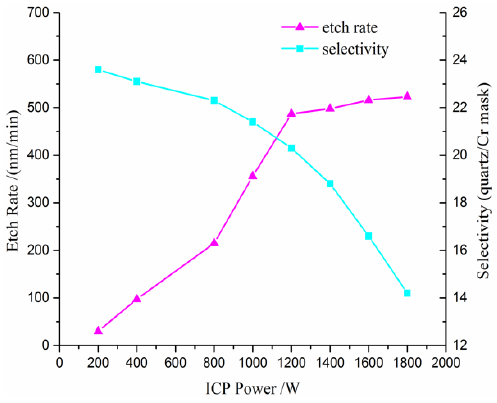
Figure 6. The etch rate of the quartz and selectivity versus the inductively coupled plasma (ICP) power.